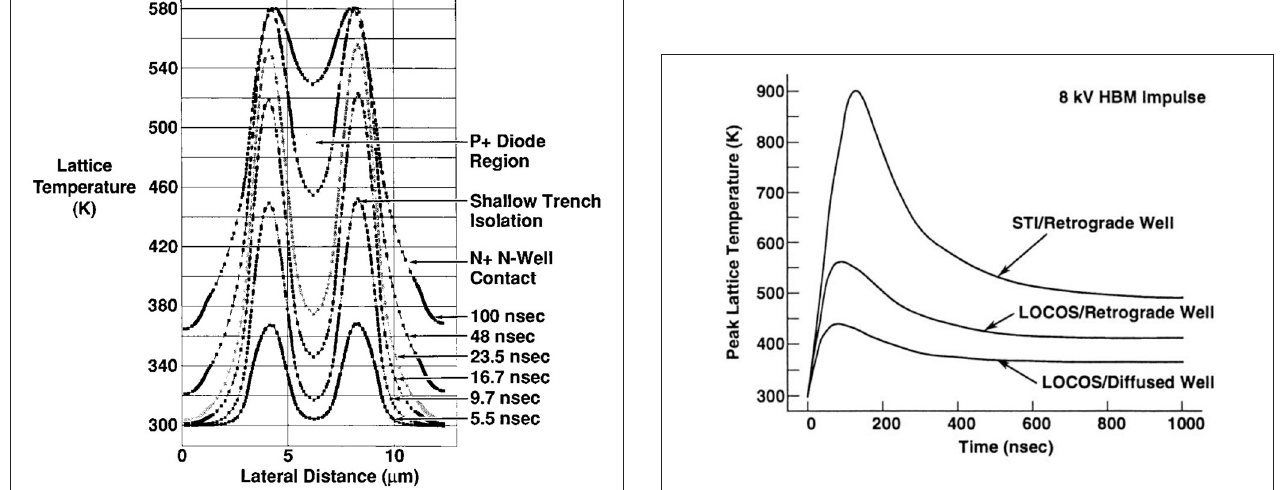
FIGURE 2 | Simulation of ESD event in p + /n + diode with 0.55 µ m deep shallow trench isolation (with permission from the ESD Association).